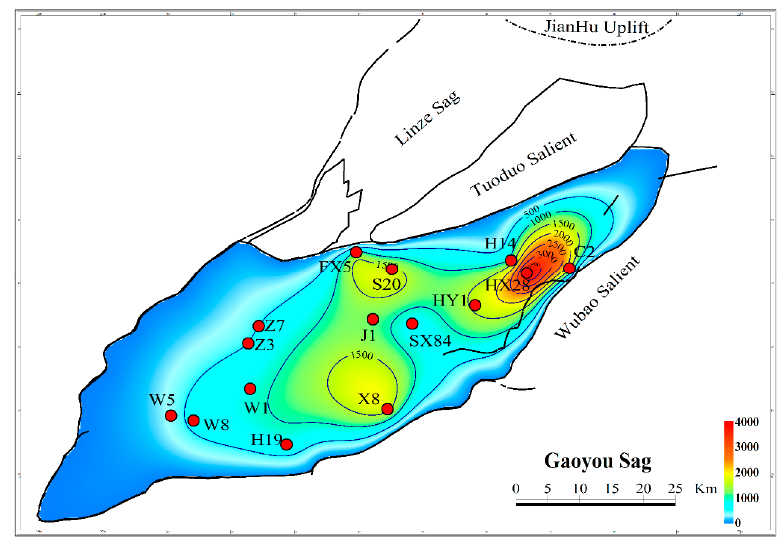
Figure 10. Contour map of the oil resource in Gaoyou Sag.